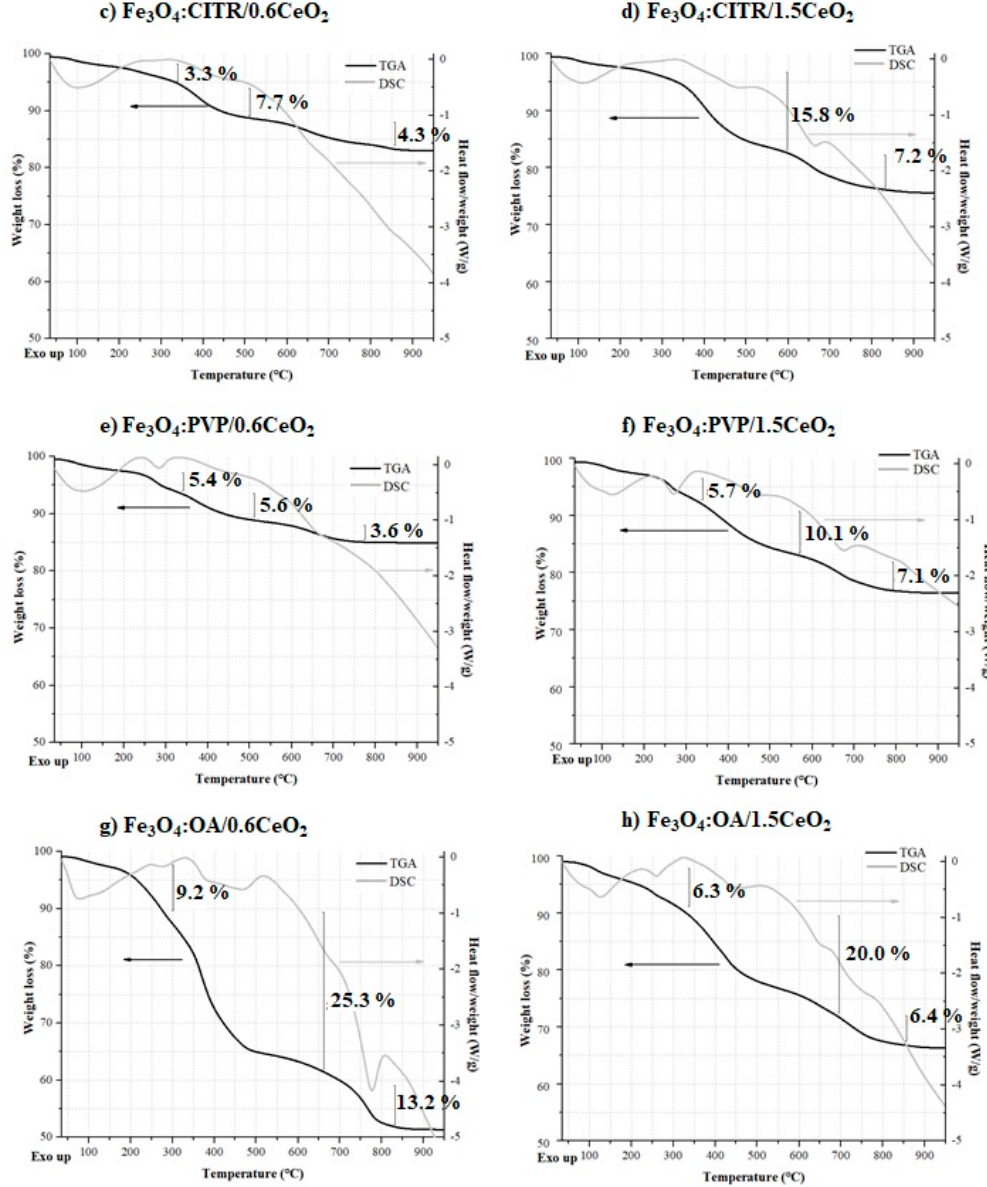
Figure 1. TGA (black) and DSC (grey) curves for: ( a ) Fe 3 O 4 / 0.6CeO 2 , ( b ) Fe 3 O 4 / 1.5CeO 2 , ( c ) Fe 3 O 4 :CITR / 0.6CeO 2 , ( d ) Fe 3 O 4 :CITR / 1.5CeO 2 , ( e ) Fe 3 O 4 :PVP / 0.6CeO 2, ( f ) Fe 3 O 4 :PVP / 1.5CeO 2 , ( g ) Fe 3 O 4 :OA / 0.6CeO 2 and ( h ) Fe 3 O 4 :OA / 1.5CeO 2